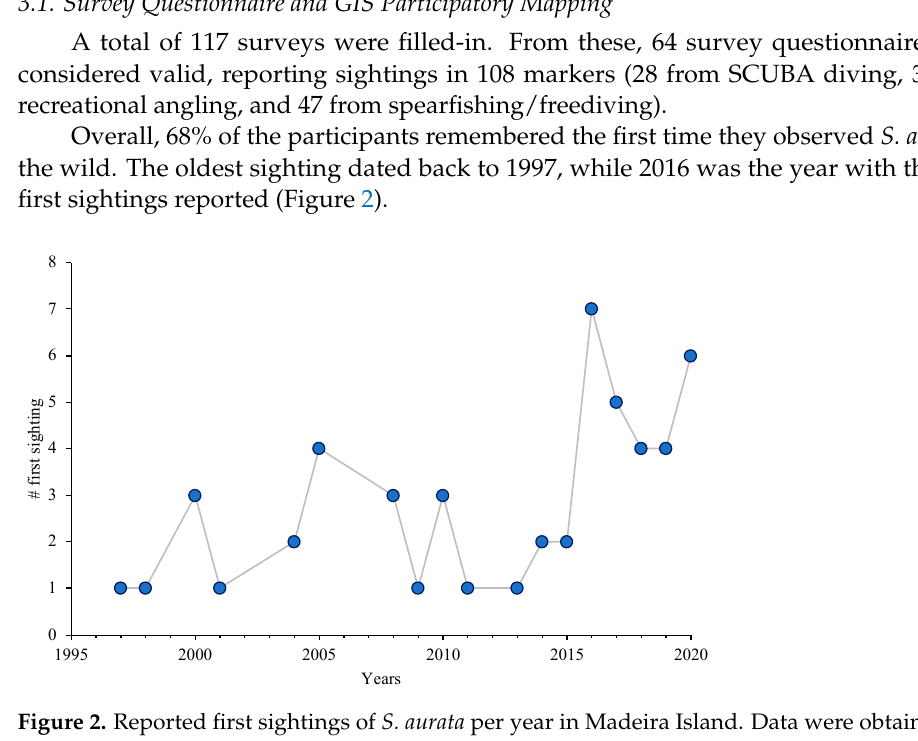
Figure 2. Reported first sightings of S. aurata per year in Madeira Island. Data were obtained with the survey questionnaire developed using Maptionnaire. Participants were asked to write the year in which they saw individuals of S. aurata for the first time in the coastal water of Madeira. The y-axis represents the number of answers.